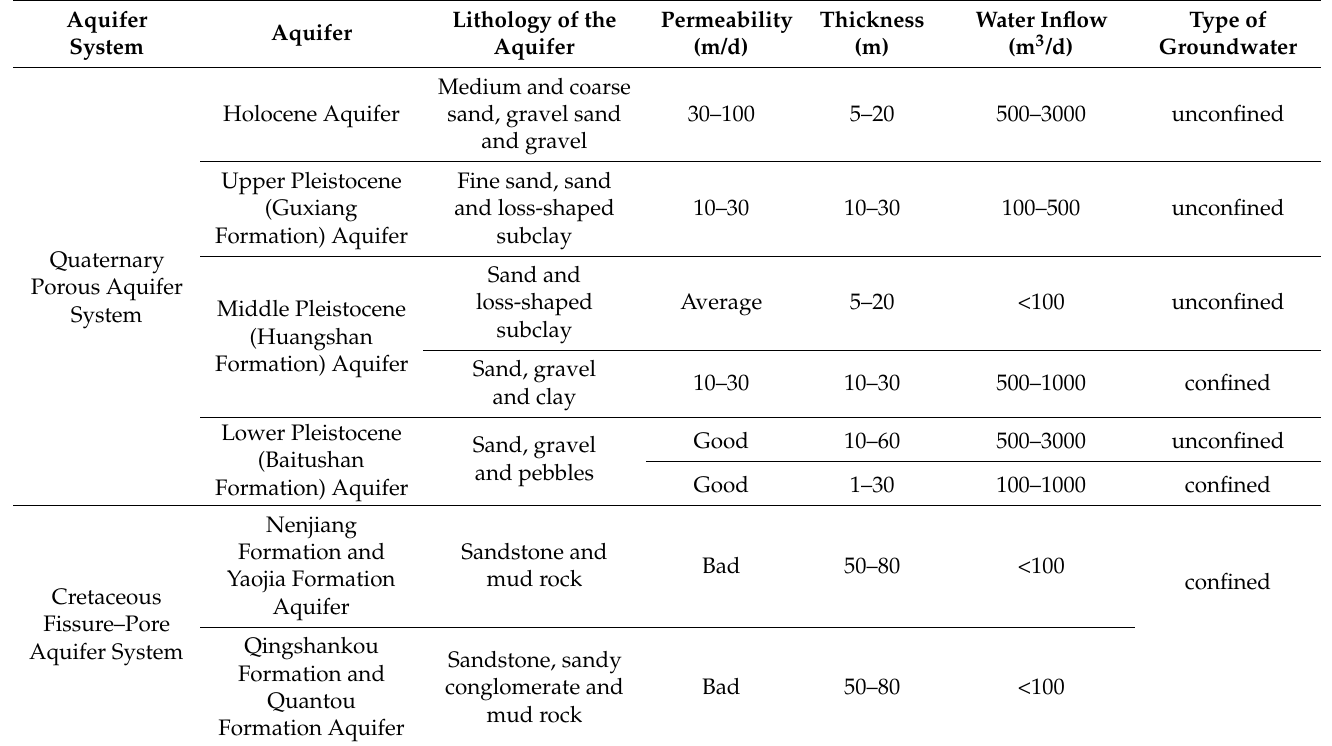
Table 1. Hydrogeological information of the aquifer systems of the study